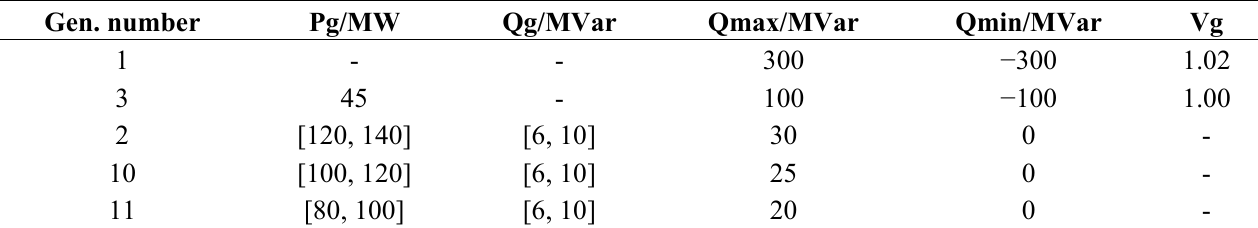
Table A2. Generator parameters.